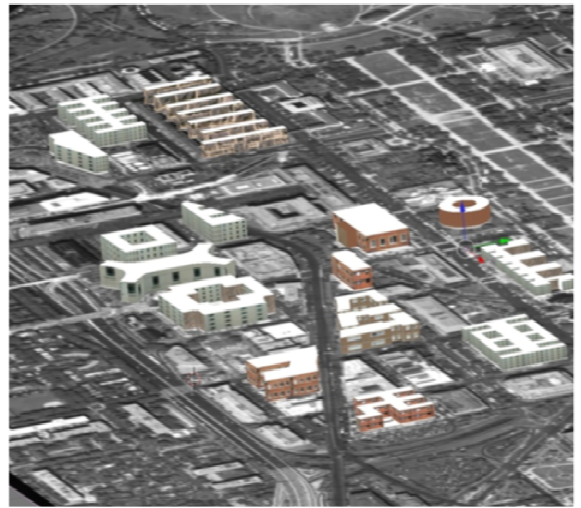
Fig. 9 A view of generated site model of portion of Washington